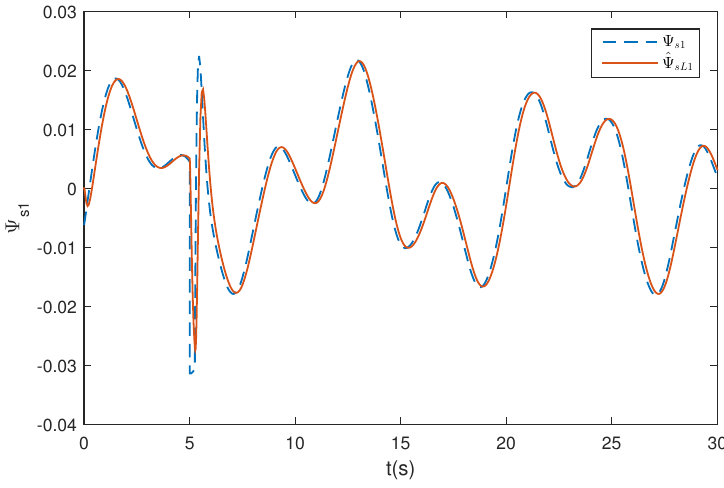
Figure 15. Estimation of Ψ s 1 using